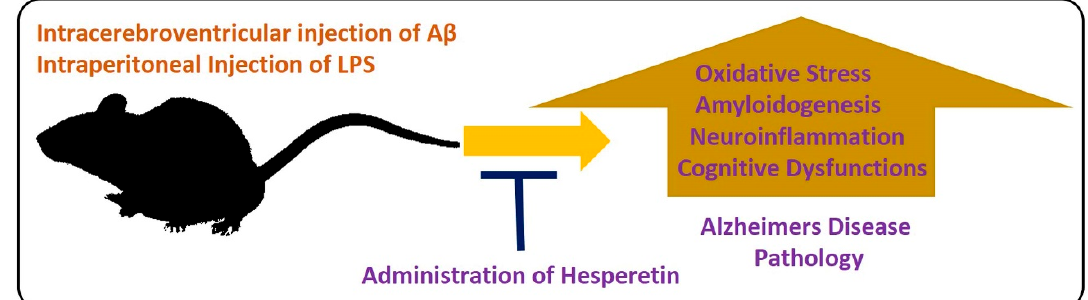
Figure 4. Role of hesperetin in the management of AD-like pathological changes in mice brains. A simple illustration showing the effects of A β and LPS on the mice’s brains. The injection of A β and LPS into the mice by intracerebroventricular or intraperitoneal injection hesperetin induces oxidative stress, amyloidogenesis, neuroinflammation, and cognitive dysfunction in the mice brains. These effects were markedly reduced with the administration of hesperetin.